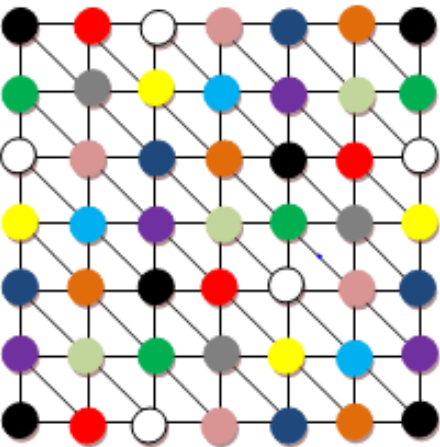
Figure 6. A 5 × 5 matrix of a network graph colored using the L(2,1,1) coloring.